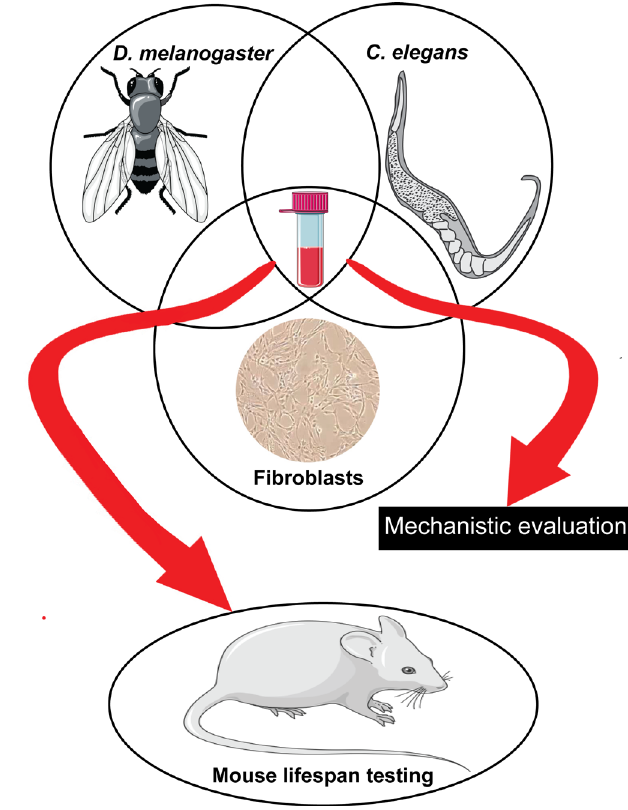
Figure 3. Approach being followed at University of Michigan for identification of compounds with potential anti-aging effects. Drugs identified for their ability to increase healthspan and lifespan in Drosophila and Caenorhabditis elegans and to enhance stress resistance in mammalian fibroblasts are potential candidates for further in-depth mechanistic evaluation and testing in